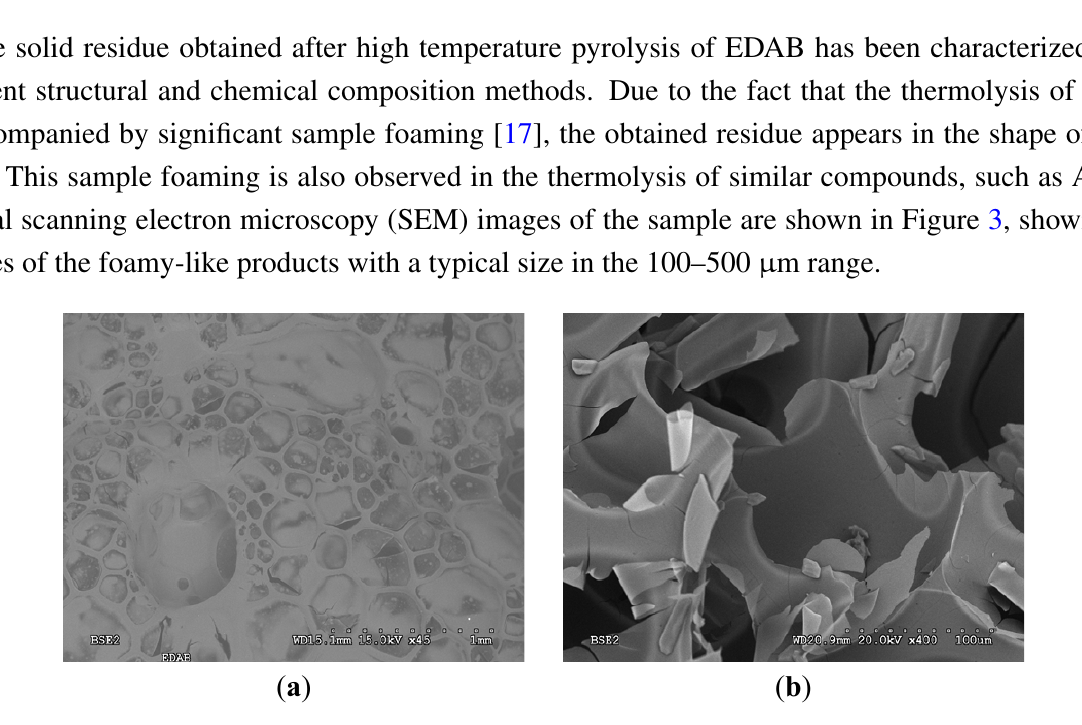
Figure 3. Scanning electron microscopy (SEM) micrographs in BSE mode (Back Scattered Electrons) of the obtained thermolysis products, taken at different magnifications: ( a ) 2220 × 2950 μ m 2 image size; ( b ) 240 × 320 μ m 2 image size.